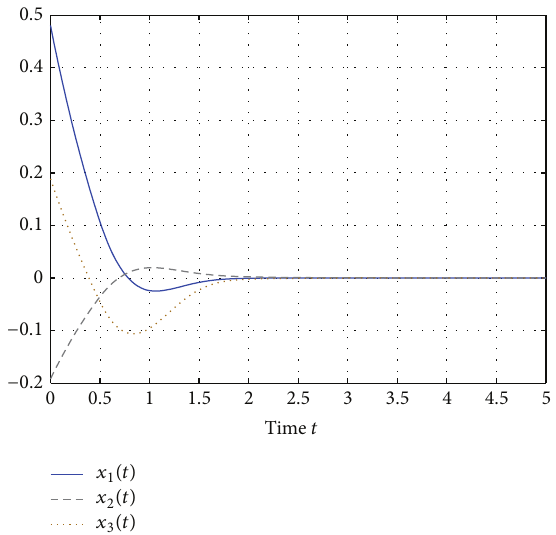
Figure 5: Error response 𝑒(𝑡) .